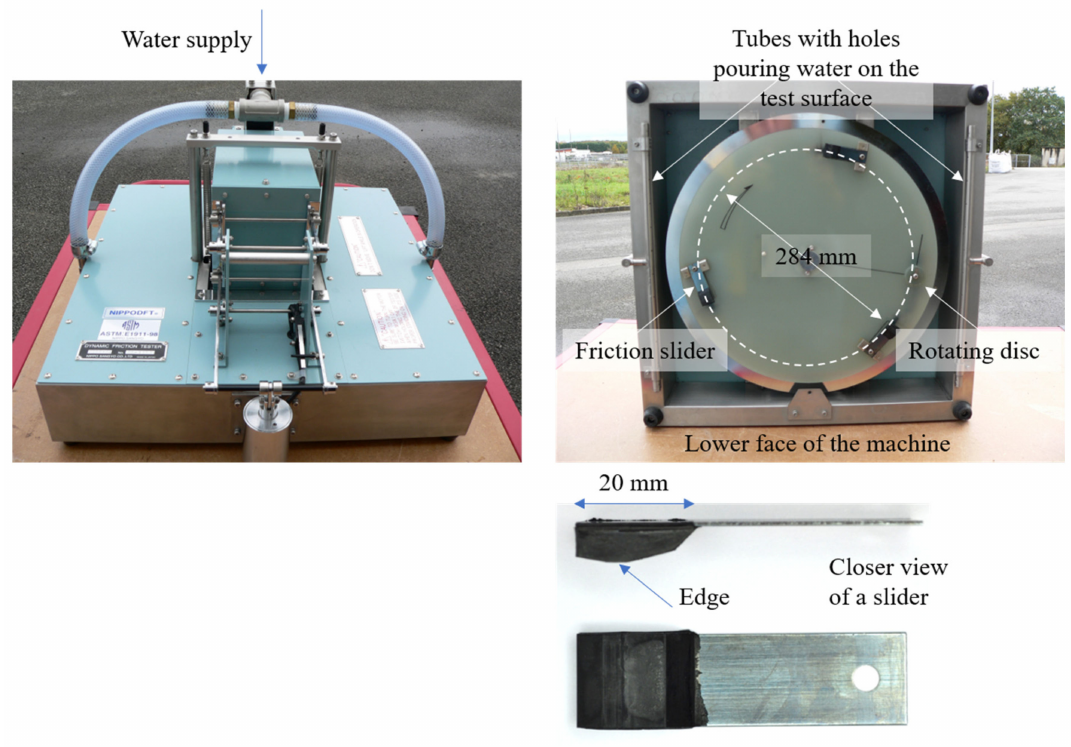
Figure 6. Dynamic Friction Tester (DFT) machine.